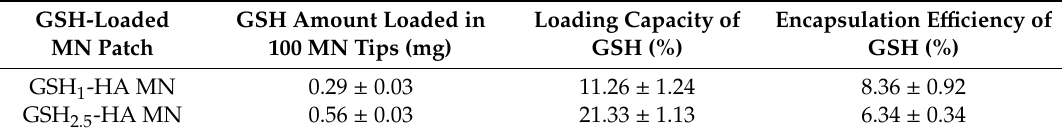
Table 1. Amount of GSH loaded in GSH-HA MN patches.